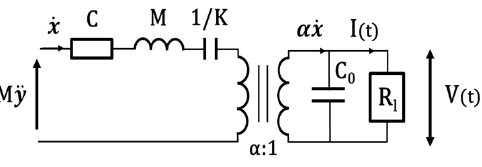
Figure 2. Equivalent electrical circuit.